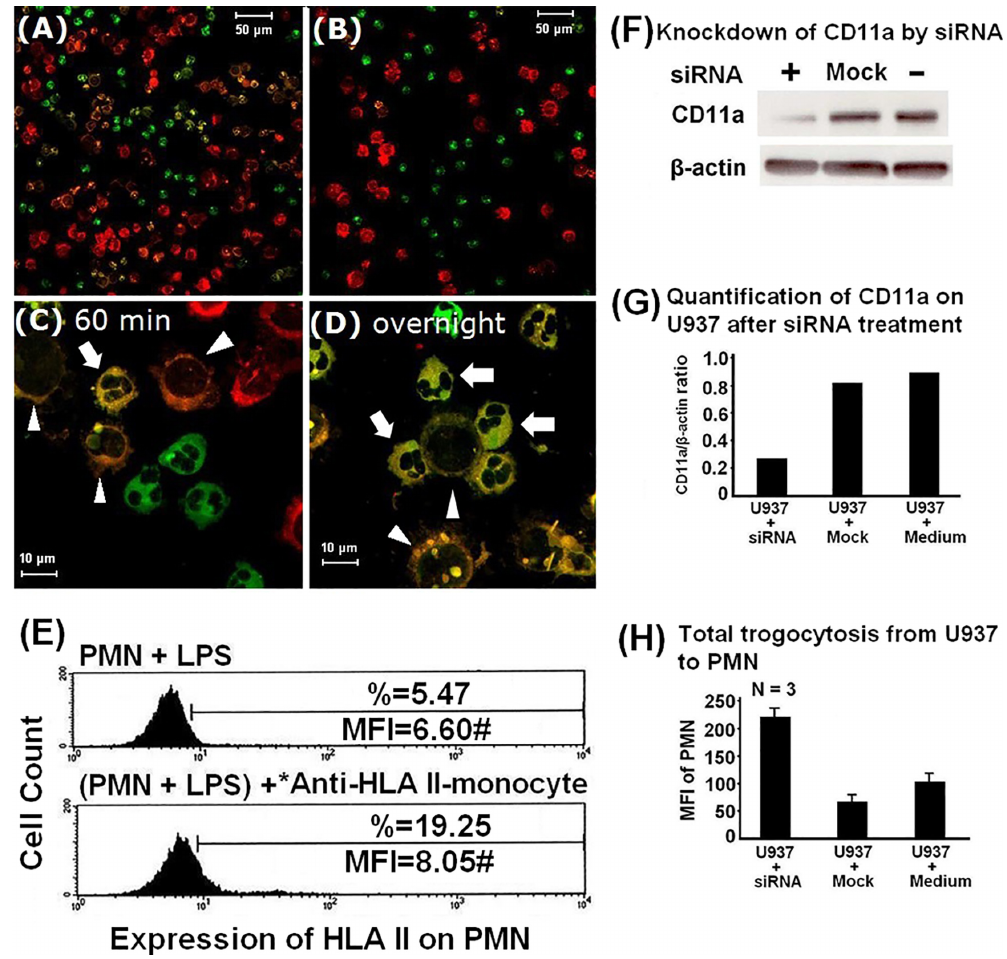
Fig 2. Trogocytosis between PMN and U937 macrophage cells with or without siRNA knockdown of CD11a. Trogocytosis between PKH-67 (green fluorescence)-labeled PMN and PKH-26 (red fluorescence)-labeled-U937 macrophage cells observed by confocal laser scan microscopy. (A) Direct cell-cell contact of PMNs with U937 cells for 1 h, demonstrating yellow fluorescence in many cells (magnification x400) (B) Transwell co-culture of PKH- 67-labeled PMNs with PKH-26 labeled U937 cells for 1 h demonstrating an absence of yellow fluorescence (magnification x400). (C) Magnification of (A) showing yellow fluorescence in a PMN (arrow) and U937 cells (arrowheads) after 1 h co-culture (magnification x1000). (D) Co-culture of PKH-67-labeled PMNs and PKH- 26-labeled U937 cells for 24 h; prominent yellow fluorescence is visible on PMNs (arrows) and U937 cells (arrowheads) (magnification x1000). (E) Results of FACS analysis demonstrating transfer of MHC class-II from human monocytes/macrophages to PMNs after co-culture for 2 h. (F) Immunoblot analysis of CD11a expression in U937 cell lysates stably transfected with specific CD11a siRNA or empty vector. (G) Densitometric quantification of CD11a in U937 cell lysates with/without siRNA knockdown by Western blot. (H) Total membrane transfer (expressed as mean fluorescence intensity, MFI) from U937 cells, with or without siRNA knockdown of CD11a, to PMNs after 2 h